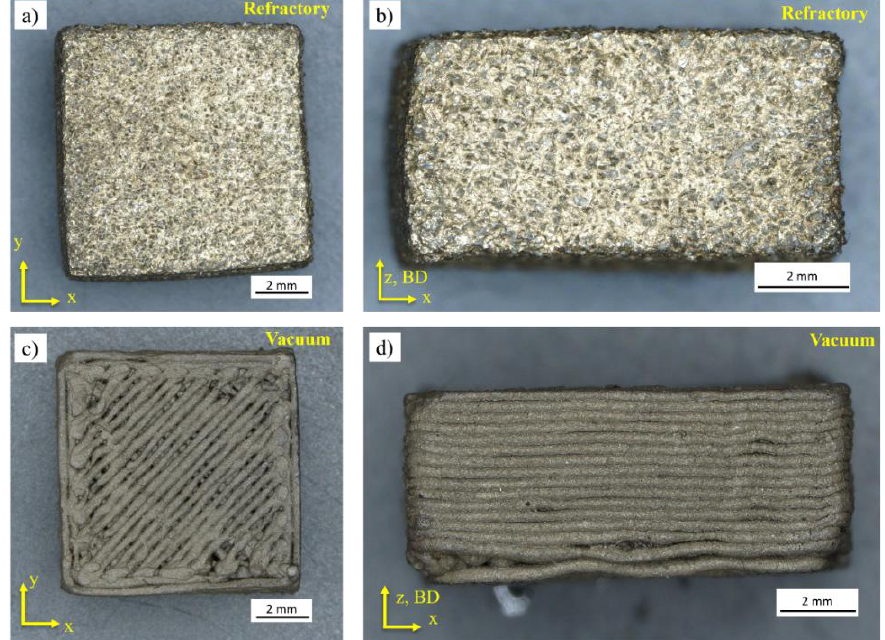
Figure 17. Indirect induction sintered specimens within the refractory ballast for a soak time of 240 s in the ( a ) XY and ( b ) ZX planes, and vacuum sintered for a soak time of 360 s in the ( c ) XY and ( d ) XZ planes.